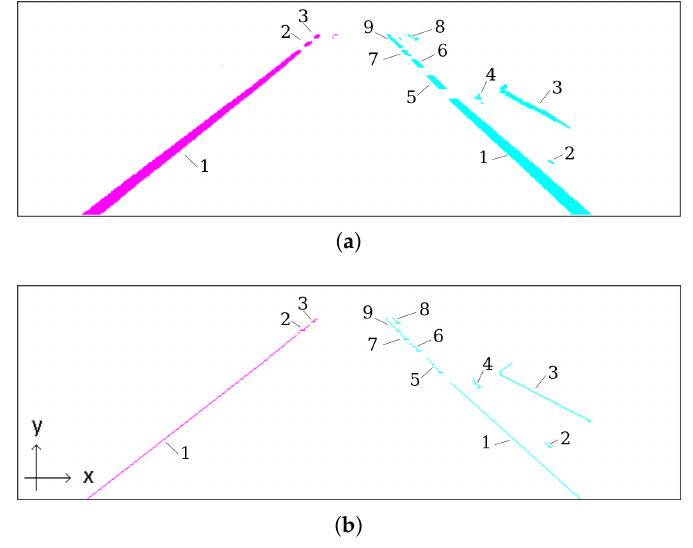
Figure 10. Building the lane marking fragments: ( a ) Blobs. ( b )